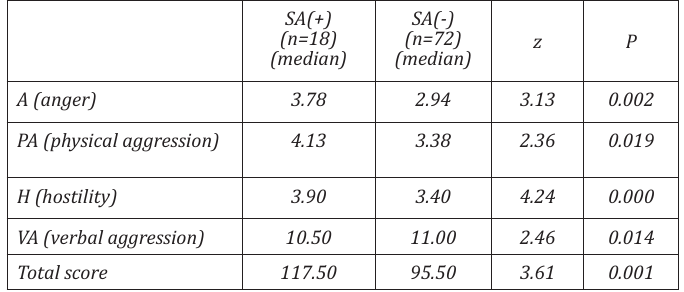
in the past have a greater personality predisposition to express aggression in the form of direct physical or verbal attacks, feelings of anger or hostile attitudes towards other people (Tab. 3). Table 3. Comparison of results obtained in the Buss and Perry aggression questionnaire by people addicted to alcohol with suicide attempts in the past and without